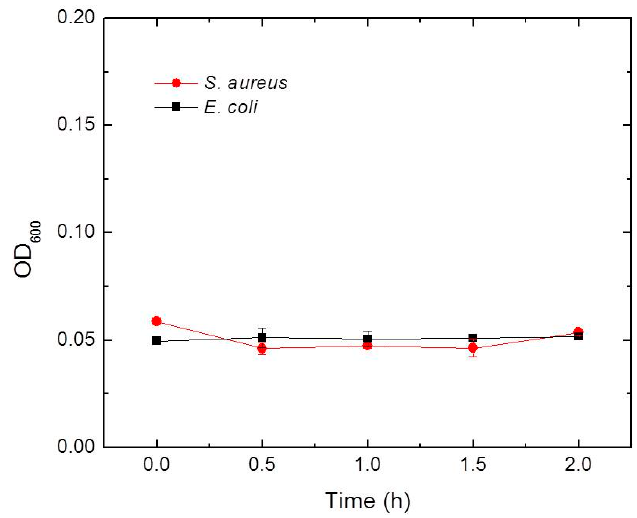
Figure 9. Growth curves of S. aureus and E. coli from agar blocks under the SF/GA/Gly/Cur composite film incubated in LB broth for 2 h as described in text.